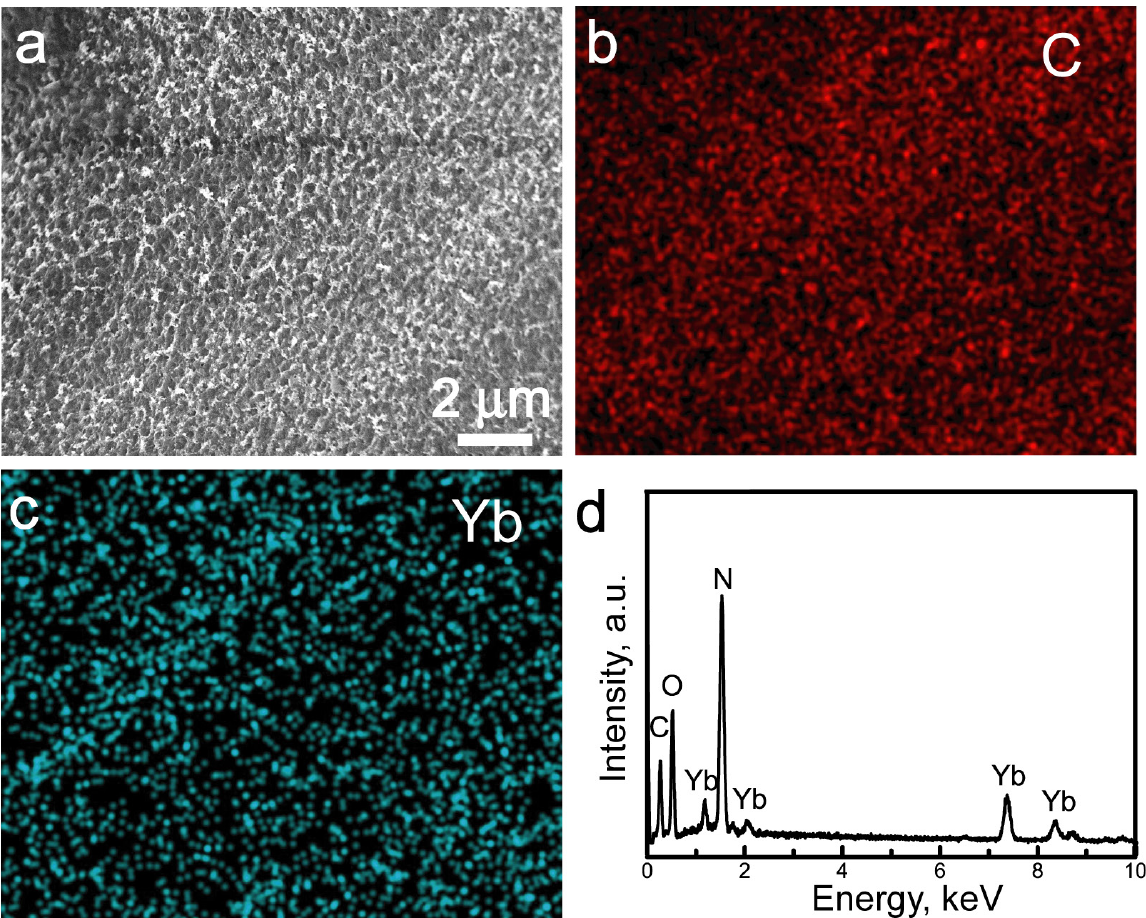
Figure 1: (a) SEM image; (b) C element distribution image; (c) Yb element distribution image; (d) EDS spectrum of the Yb-CS hydrogels